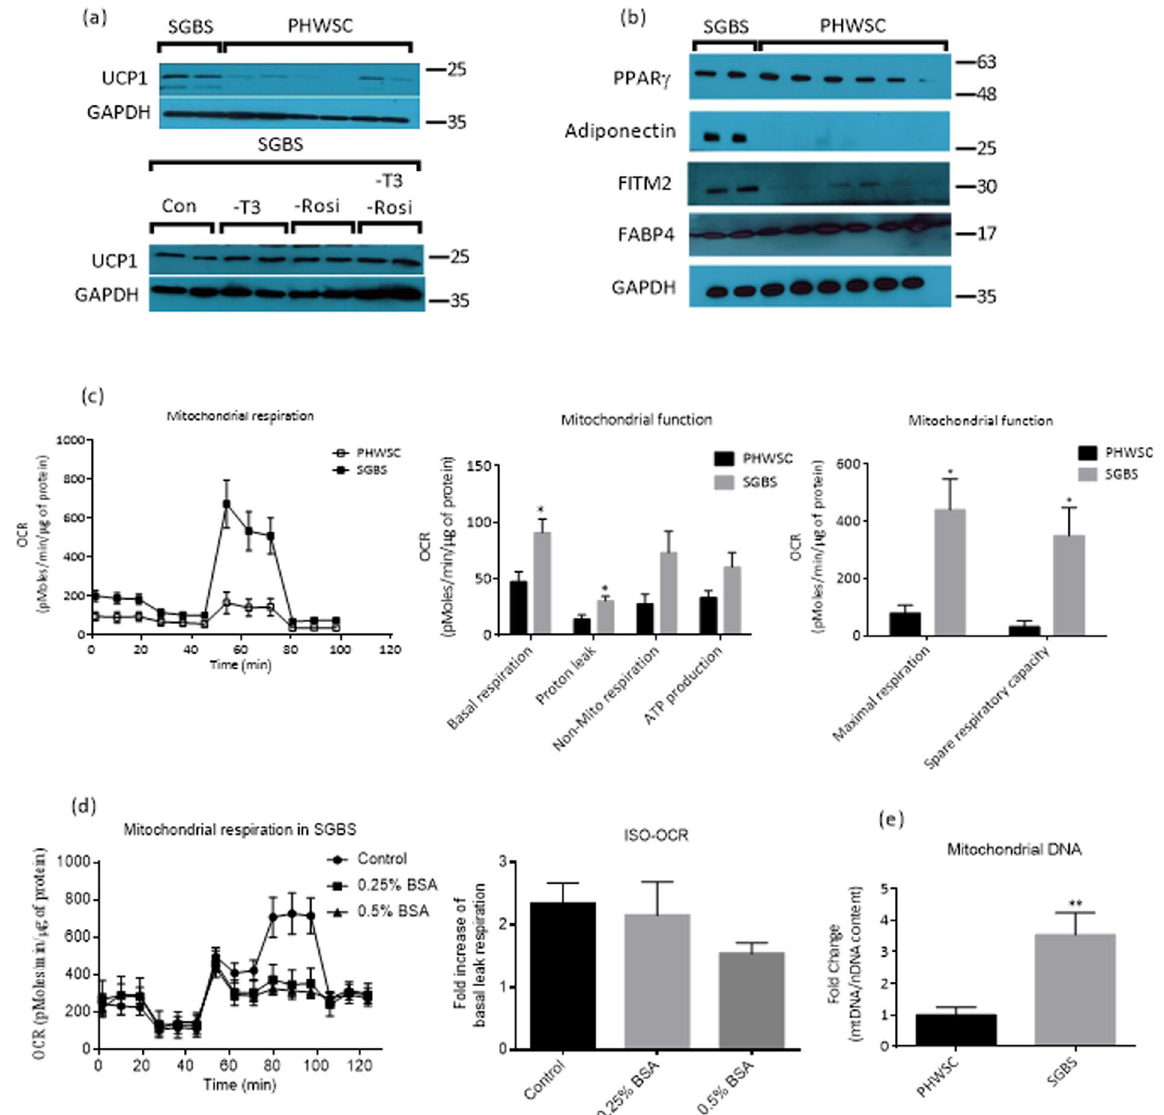
Figure 3. UCP1 protein expression and mitochondrial respiration in SGBS adipocytes display characteristics suggestive of browning capacity. ( a ) Top panel: UCP1 protein expression in differentiated SGBS and PHWSC adipocytes. Bottom panel: UCP1 protein expression in SGBS adipocytes differentiated in medium depleted with either T3 or rosiglitazone or both. ( b ) Protein expressions of adipogenic and lipid metabolism markers including PPAR γ , adiponectin, FITM2 and FABP4 in differentiated SGBS and PHWSC adipocytes. ( c ) Mitochondrial respiratory function or oxygen consumption rate (OCR) measured by Seahorse mitochondrial flux analyser. Bar graphs denote functional readouts of mitochondrial oxidative capacity. ( d ) Representative time course of OCR of ISO-treated SGBS adipocytes in the presence of either 0%, 0.25% or 0.5% FAF BSA, as well as UCP1-mediated basal leak respiration in SGBS adipocytes. ( e ) Relative mitochondrial DNA content in SGBS and PHWSC adipocytes. UCP1 protein blots were cropped for a more concise presentation and the respective full-length blots are available in supplementary Fig. S4. For the experiments involving PHWSC adipocytes, experiments were performed in duplicates from cells derived from 3 different donors. For SGBS adipocytes, experiments were performed in duplicates during 3 independent experiments from the same SGBS adipocyte. Data are expressed as means ± SD. * P <